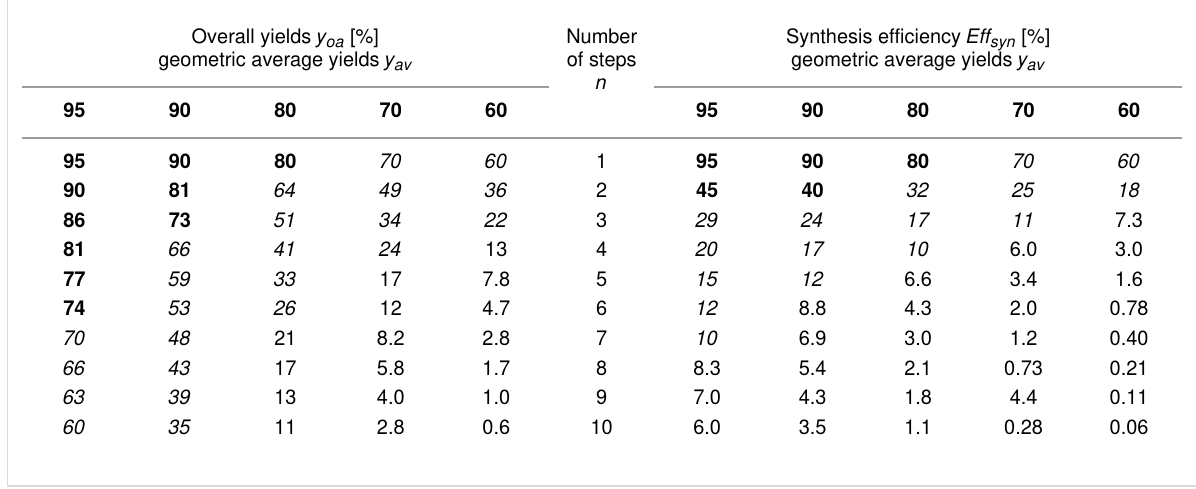
Table 1: Overall yields y oa and synthesis efficiency Eff syn